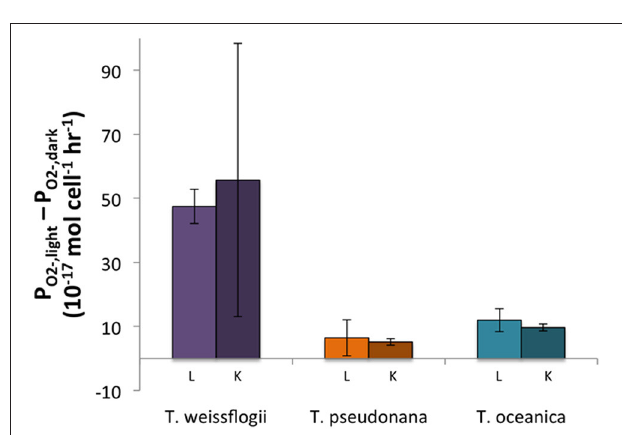
FIGURE 2 | Differences between light and dark P O2 − for both live (L) and killed (K) cultures in Thalassiosira spp. Error bars represent one standard